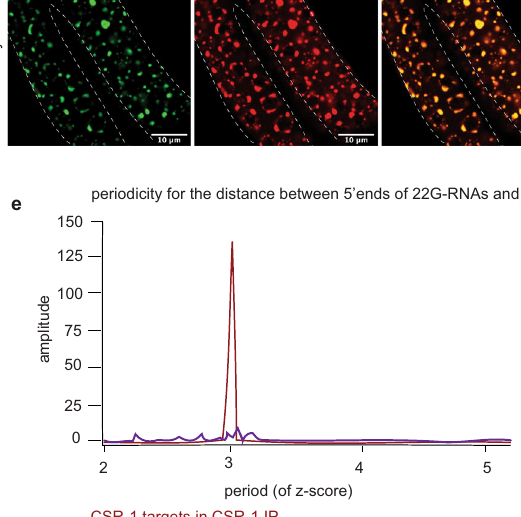
number (Fig. 5c and Supplementary Fig. 8b, d) and tRNA expression in the late L4 worm population (44 h) as measured by GRO-seq (Fig. 5d and Supplementary Fig. 8c, e). We noticed that for codons with no tRNA cognates and requiring tRNA binding by wobble pairing, all optimal codons end with C and non- optimal with U. Translation elongation is lower for those ending with a U 47 .